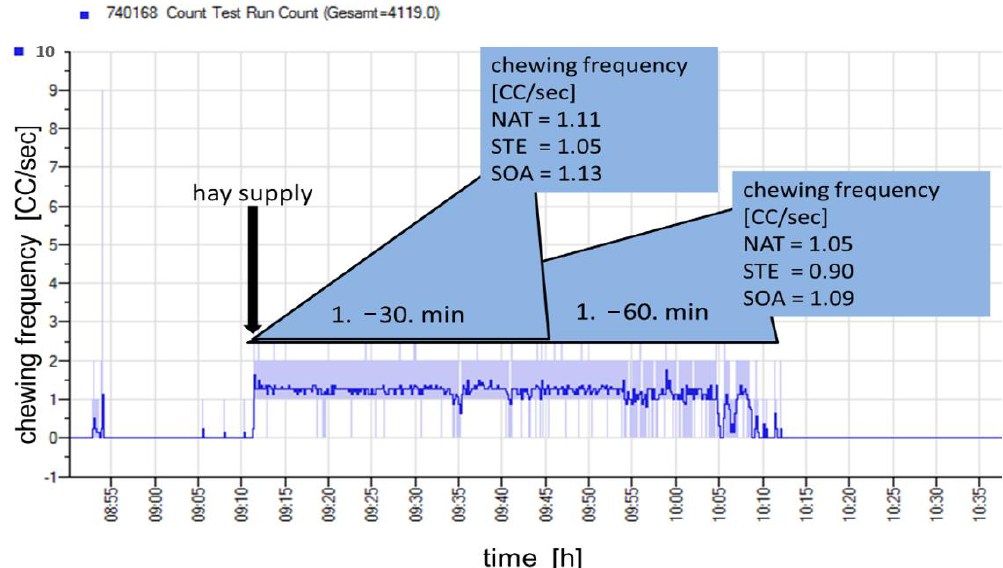
Figure 2. Data sheet from chewing frequencies detected during hay intake. CC, chewing cycle; NAT, native hay; SOA, soaked hay; STE, steamed hay.